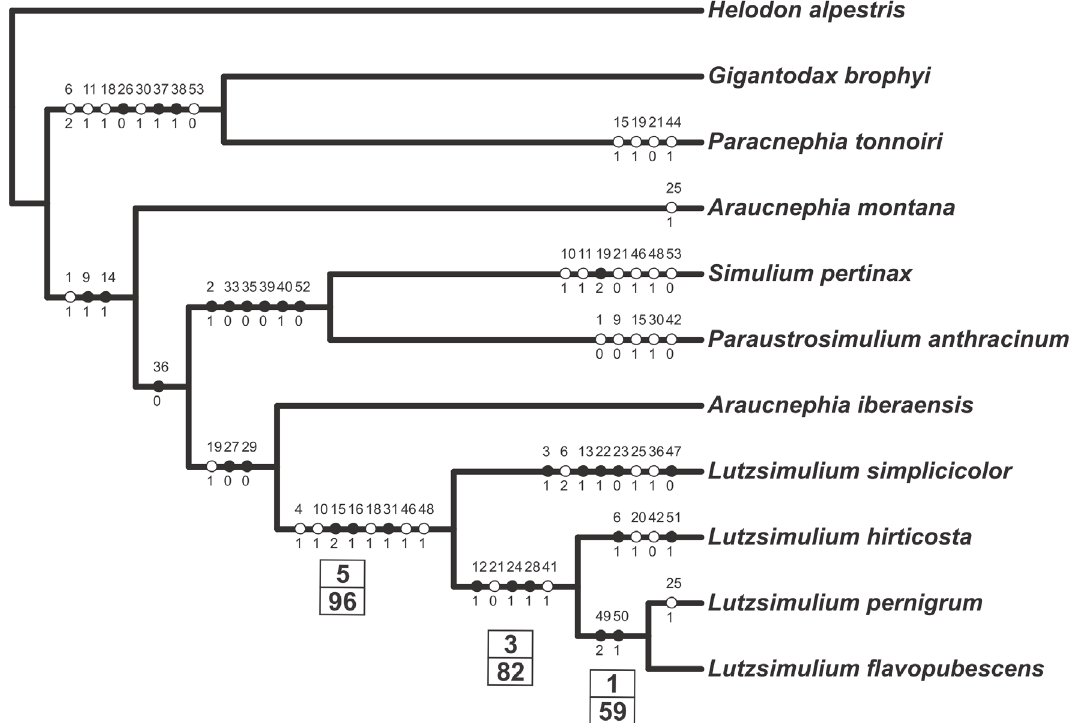
Figure 1. One of two trees obtained with maximum parsimony, unweighted characters, chosen to represent the phylogenetic relation- ships of the Lutzsimulium (81 steps, consistency index = 0.65 and retention idex = 0.71, not considering the autapomorphic characters). Only unambiguous apomorphies are represented in the diagram; circles represents apomorphies (white = homoplastic; black = non- homoplastic); the numbers above the circles represent characters and the numbers below refer to character states. Branch support in the boxes: decay index (above) and bootstrap